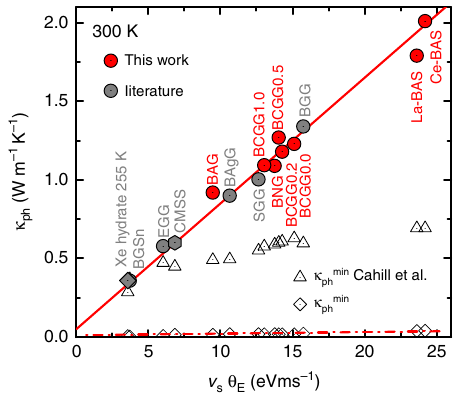
Fig. 5 Universal scaling of the intrinsic phonon thermal conductivity of phonon Kondo compounds. Phonon thermal conductivities vs the product of sound velocity and lowest-lying Einstein temperature (Supplementary Note 5) for single crystalline intermetallic clathrates measured within this work (red circles), together with published data on intermetallic clathrates (grey circles), a Xe- fi lled ice hydrate (grey square), and the tetrahedrite Cu 10.6 Mn 1.4 Sb 4 S 13 (CMSS, grey hexagon; see Supplementary Table 1 for all sample compositions and references). The open triangles are the minimum κ κ 45 . The open squares are the minimum ph values derived using min of ref. κ ph values estimated as discussed in Supplementary Note